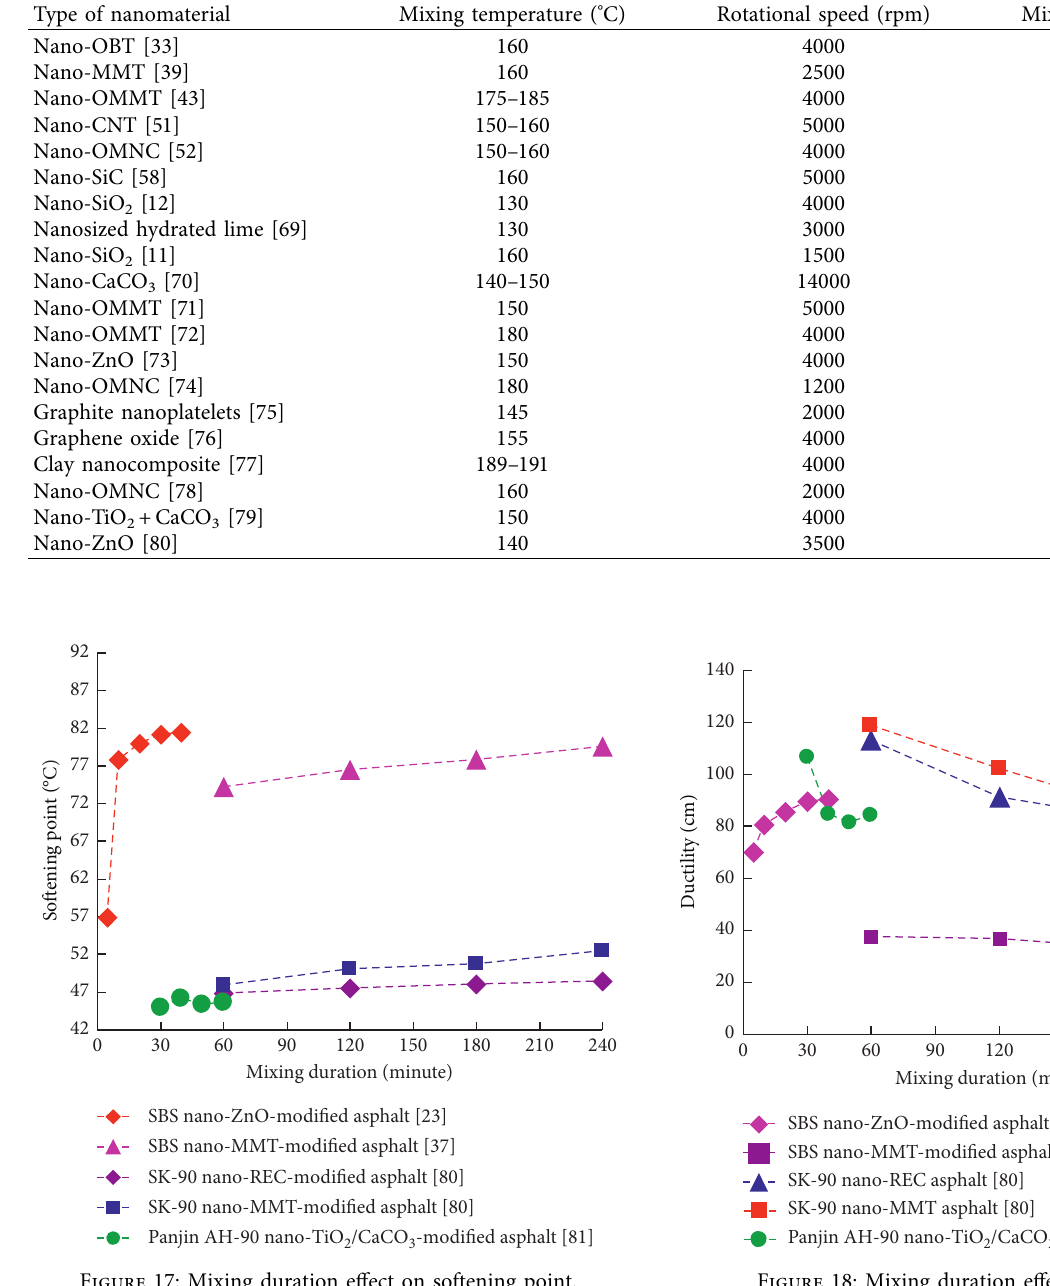
Table 1: Typical preparation parameters used by various researchers.